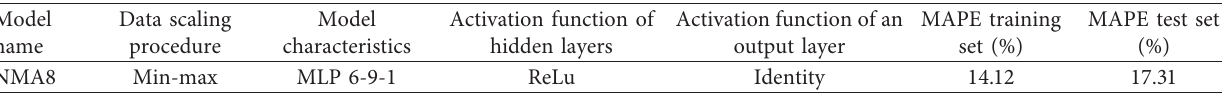
Table 12: Artificial neural network models with random data choice for estimating reinforcement consumption (LOOCV).